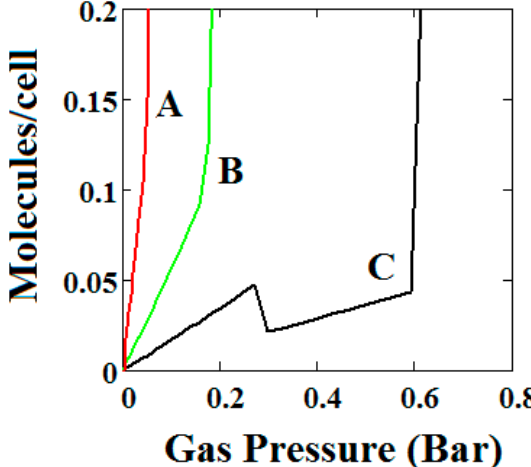
Figure 9. Plot of the behaviour of the methane adsorption in the theory MOF for three pairs of differences in values of the LP and NP heats of adsorption ( A = − 13.00/ − 18.96, B = − 16.6/ − 13.55, C = − 14.8/ − 13.55 kJ/mole). Curve C shows a NGA transformation at low pressure on the left. For the NGA transformation to occur, the LP, NP heats of adsorption should be close in magnitude. The other parameters are T = 257 K, J = 1.08 kJ/mole, ∆ = 0.025 kJ/mole, X = 5000 Å 3 , Y = 10,000 Å 3 , Nm = 40, scale = 0, nmaxlp = 21, nmaxnpb = 20.